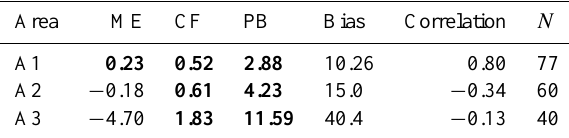
Table 1. Statistical indicators of model skill for surface ocean p CO 2 in the three areas (A1, A2 and A3 – Fig. 4). The indicators are the following: ME (Model Efficiency); CF (Cost Function) and PB (Percentage of Bias). Additionally, showing total bias (µatm), corre- lation and total number of observations ( N ) available on each area. Bold values indicate “good/reasonable” model